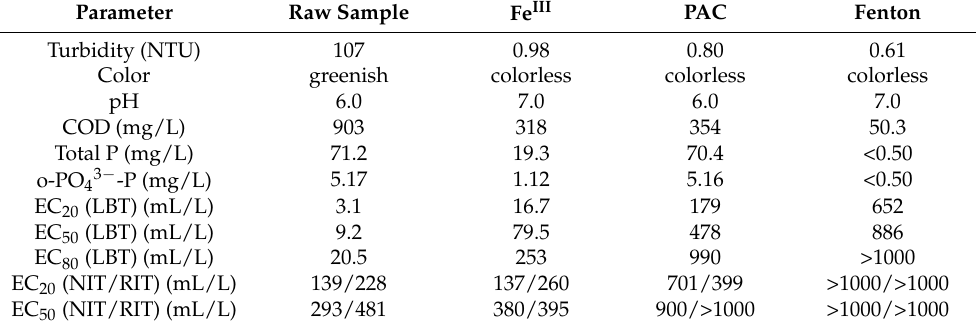
Table 1. Comparison of different parameters of raw sample A before and after treatment with 81 mg/L of 10 L